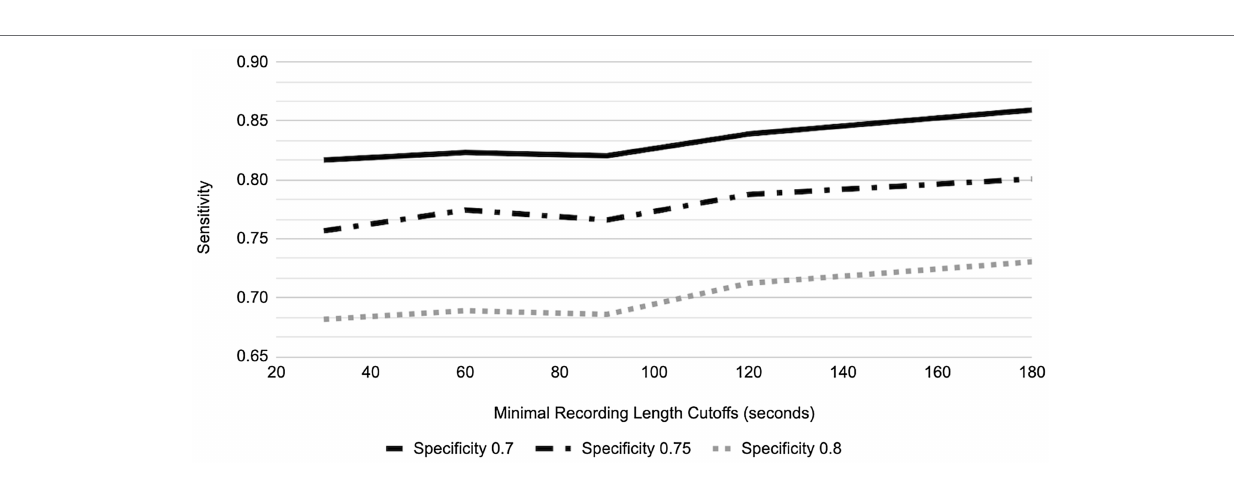
FIGURE 6 | Sensitivity vs. Specificity in relation to recording length cutoffs for